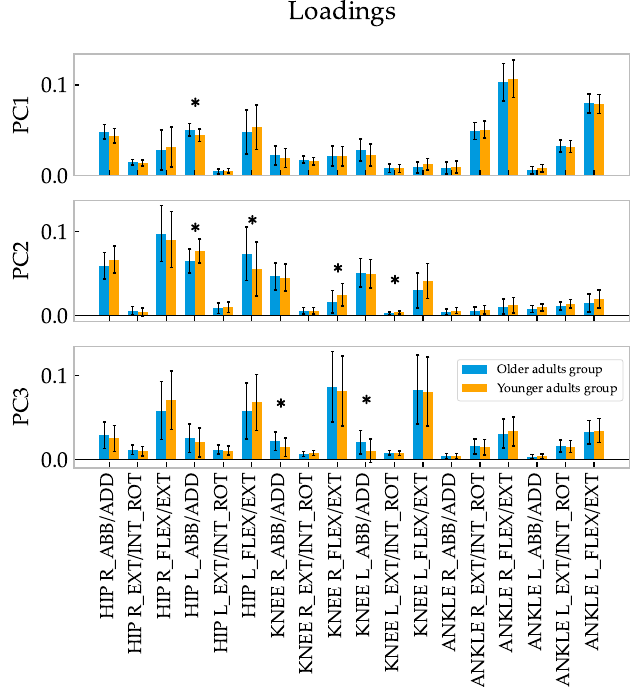
Figure 3. Loadings for each kinetic PC. R/L: right/left lower limbs; ABB/ADD, EXT/INT ROT, and FLEX/EXT represent the abduction/adduction moments, external/internal rotation moments, and flexion/extension moments, respectively. ( ∗ p < 0.05 ) .